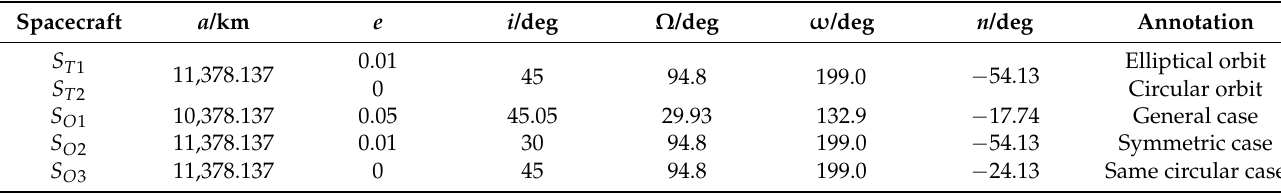
Table 1. Nominal orbital elements for observability analysis.